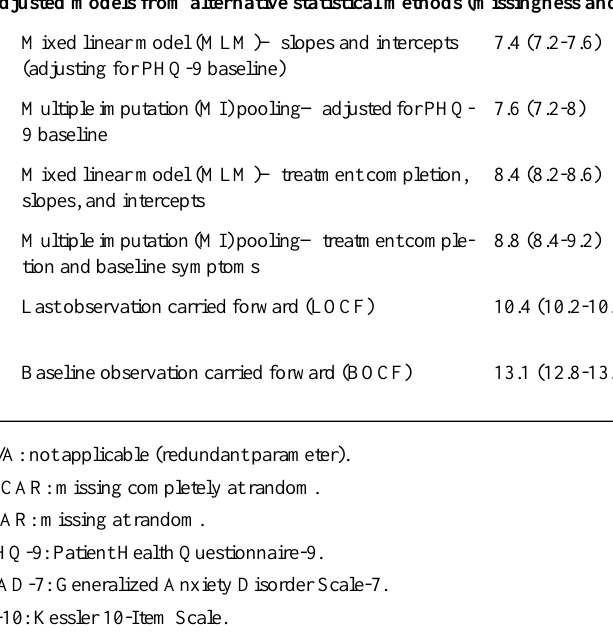
Adjusted models from alternative statistical methods (missingness and PHQ-9 outcome